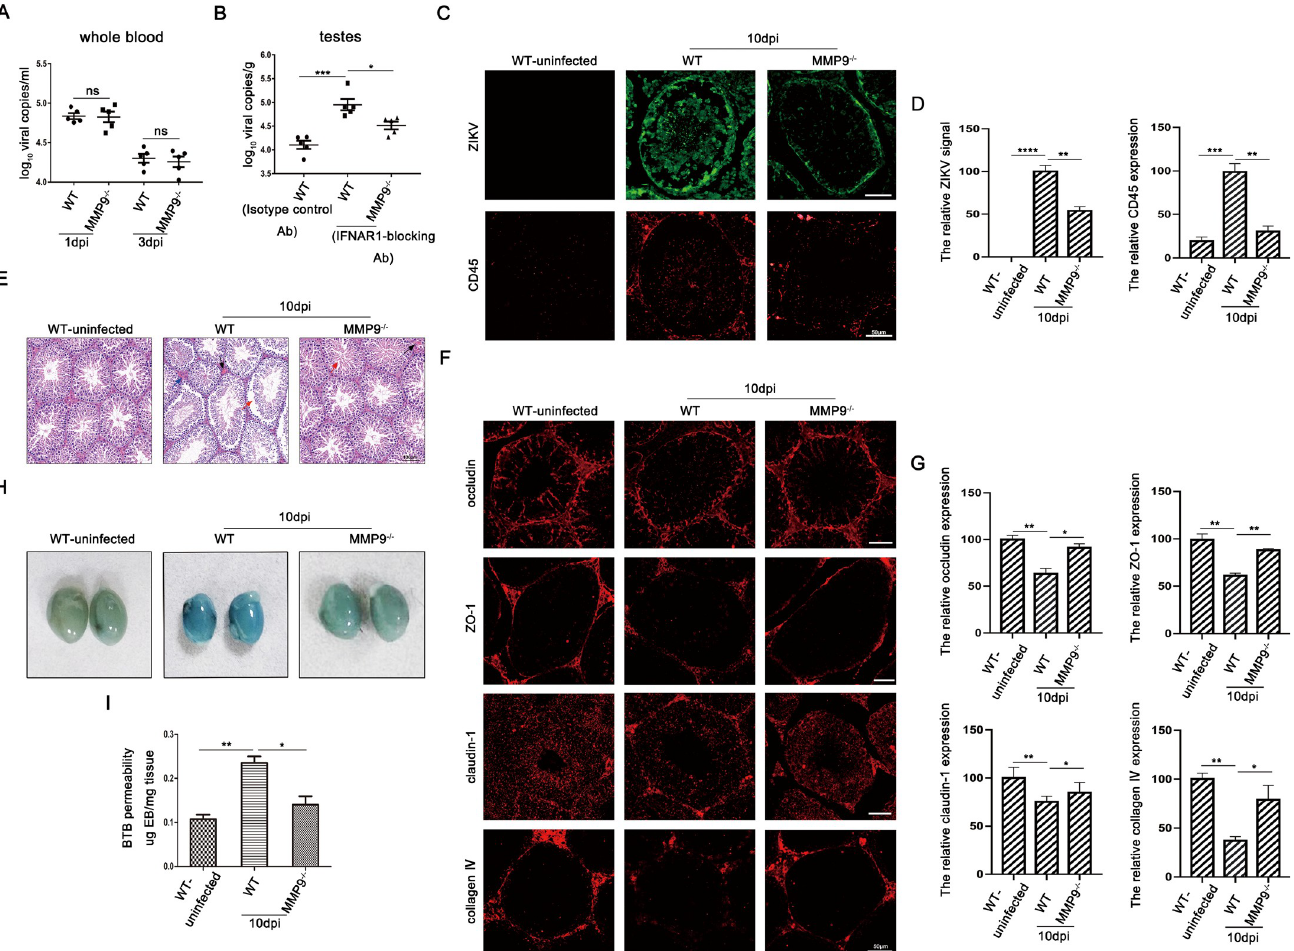
Fig 2. MMP9 compromised BTB integrity to facilitate ZIKV entry into the testes. C57BL/6 WT and MMP9 -/- male mice (6–7 weeks old) treated with Ifnar- blocking mouse monoclonal antibodies were infected intraperitoneally with ZIKV (1 × 10 7 PFU). The C57BL/6 WT mice treated with isotype control antibodies were also infected intraperitoneally with ZIKV (1 × 10 7 PFU) as a mock control. (A) RNA was extracted from the whole blood, and a probe-based assay was used to quantify viral RNA copy number by TaqMan qPCR amplification of ZIKV E gene at different time points. Data shown are means ± SEMs; ns, not significant, n = 5. (two-tailed Student’s t-tests). (B) RNA was extracted from the testes, and a probe-based assay was used to quantify viral RNA copy number by TaqMan qPCR amplification of ZIKV E gene at different time points. Data shown are means ± SEMs; � P < 0.05; �� P < 0.01; ��� P < 0.001, n = 5. (one-way ANOVA). (C and D) Results of immunofluorescence staining for ZIKV (green) and CD45 (red) in the testes and the quantifications were shown using Image J. Data shown are means ± SEMs; � P < 0.05; �� P < 0.01; ��� P < 0.001, ���� P < 0.0001, n = 5 (one-way ANOVA), Scale bar, 50 μ m. ( E ) Histopathological changes in the testes of WT and MMP9 -/- mice on day 10 post infection. Disrupted seminiferous tubules with leukocyte infiltration (blue arrow), abnormally organized cells (red arrow), and intratesticular congestion (black arrow) were obviously observed in ZIKV-infected WT testes. Representative images from several independent experiments are shown, Scale bar, 100 μ m. ( F and G ) Results of immunofluorescence staining of occludin (red), ZO-1 (red), claudin-1 (red), and type IV collagen (red) and the quantifications for the percentage of these proteins were shown using Image J. Data shown are means ± SEMs; � P < 0.05; �� P < 0.01, n = 5 (one-way ANOVA), Scale bar, 50 μ m. ( H ) Evans blue BTB permeability. On day 10 postinfection, WT and MMP9 -/- mice were injected with Evans blue and perfused 1h later. Uninfected WT mice were used as a control. Data are representatives of the results of three experiments (n = 8/group). ( I ) Quantification of Evans blue in the mouse testes. Evans blue was extracted from whole testes, and absorbance was measured, using uninfected-mouse testis extracts as a blank. � P < 0.05; �� P < 0.01. ns, not significant (one-way ANOVA). expression of MMP9 in human embryonic kidney cells (HEK293T) after ZIKV infection at dif- ferent multiplicity of infection (MOI) (S2A Fig). Taken together, these findings demonstrated that MMP9 was upregulated both in time-dependent and ZIKV-dose dependent manners by ZIKV infection.